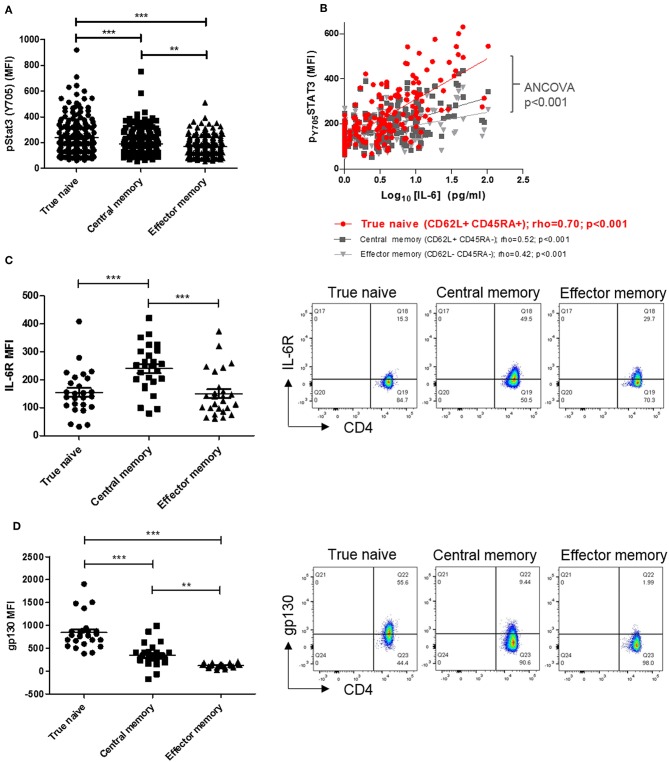
(A) pSTAT-3 expression was determined in true naïve (TN; CD62L+ CD45RA+), central memory (CM; CD62L+ CD45RA-), and effector memory (EM; CD62L- CD45RA-) CD4+ T-cells in peripheral blood of a previously described early arthritis patient cohort (3) using flow cytometry. (B) In the same cohort, the relationship between pSTAT-3 and paired circulating interleukin (IL)-6, measured by MSD immunoassay, was assessed by Spearman correlation coefficients (rho); gradients of best-fit lines differ significantly (analyses of covariance p < 0.001). Amongst newly-enrolled early arthritis patients (cohort A; see Table 1), surface IL-6R expression (C) and surface gp130 expression (D) was determined in TN, CM and EM CD4+ T-cells in the peripheral blood using flow cytometry [left panels; n = 26; **p < 0.001, ***p < 0.0001, non-parametric analysis of variance (Friedman's) with Dunn's post hoc pairwise analyses; associated p-value are depicted]. Exemplar FACS plots are also shown (right panels).